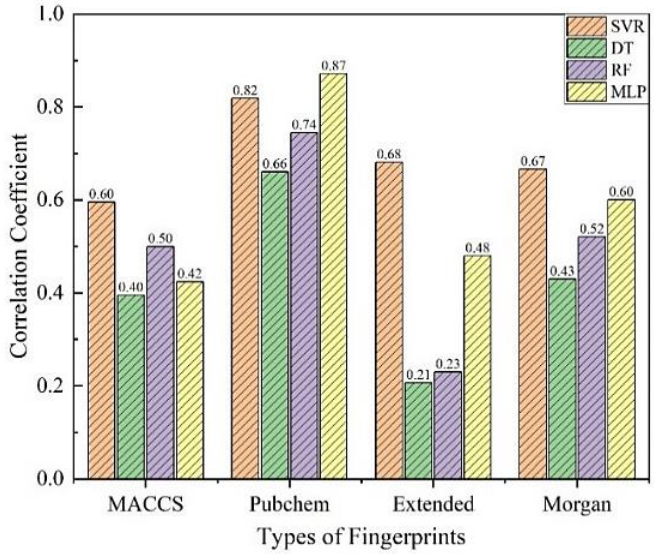
Figure 2. Predictive performance of each model on the testing set.